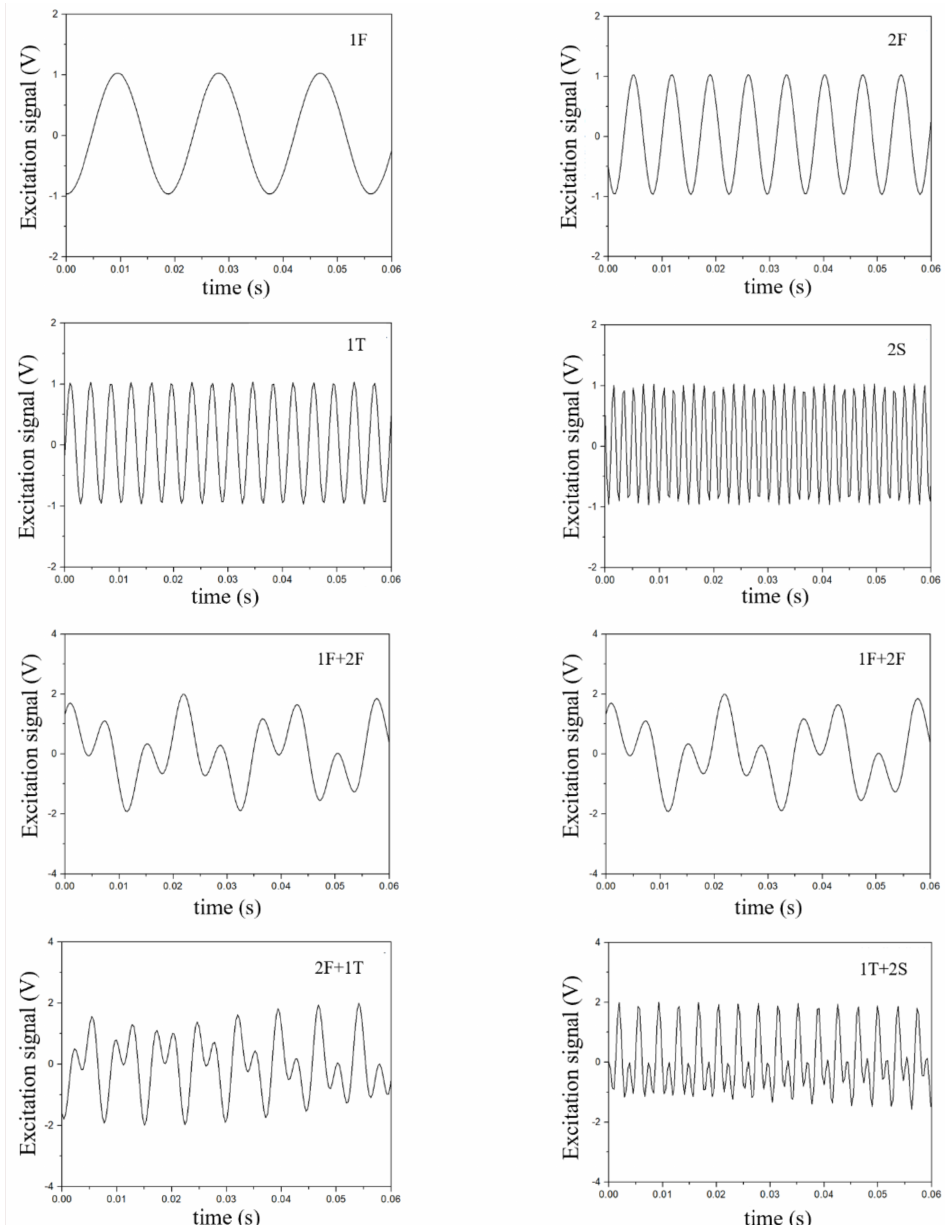
Figure 10. Time history of single frequency signals and superposition of two frequency